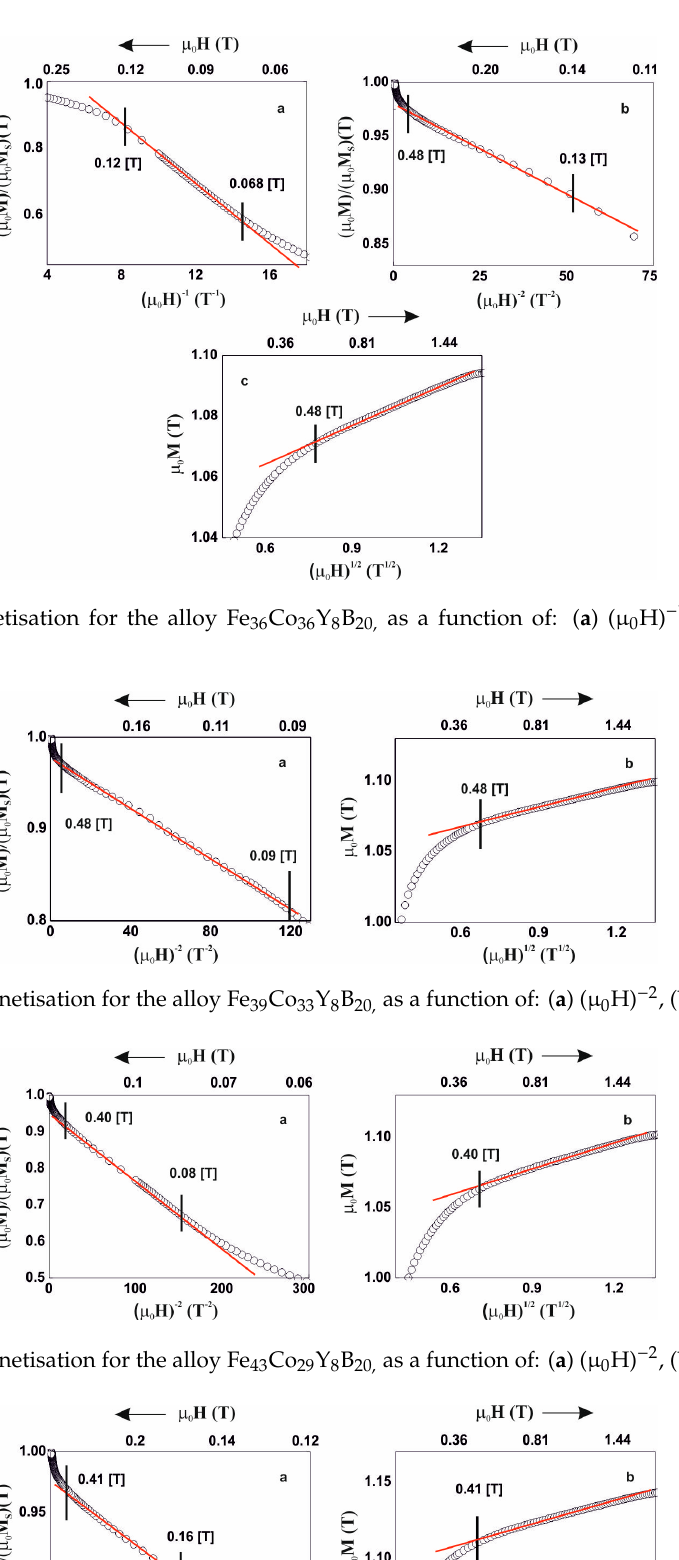
Figure 9. Magnetisation for the alloy Fe 48 Co 24 Y 8 B 20, as a function of: ( a ) (µ 0 H) − 2 , ( b ) (µ 0 H) 1/2 .